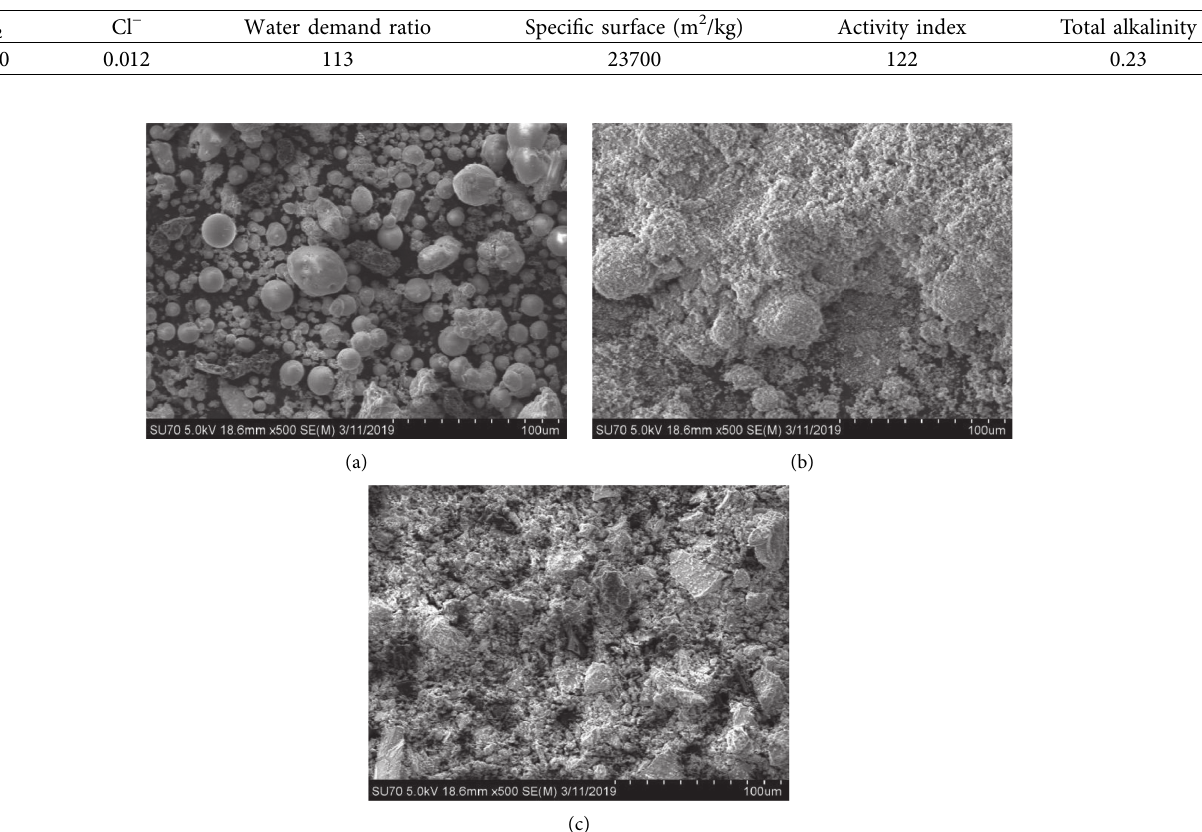
Figure 1: SEM micrographs of (a) fly ash, (b) CFBC ash, and (c) CFBC